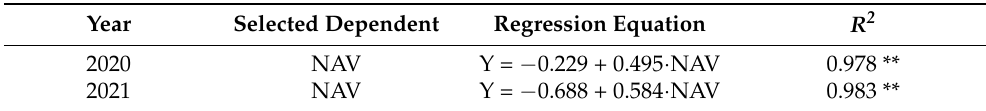
Table 7. Stepwise regression of GPC to grain yield, dry matter production and nitrogen accumula- tion traits.